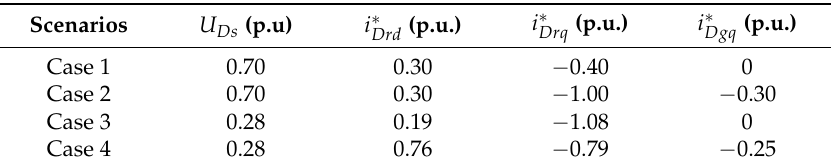
Table 1. Parameters of four simulation